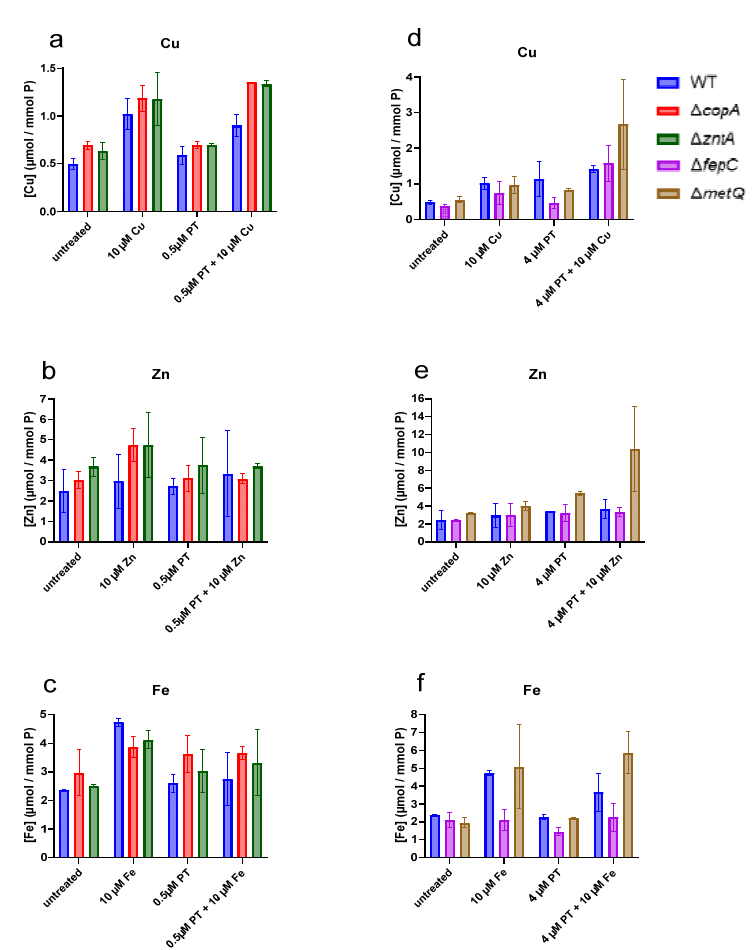
Figure 8. Cell-associated Cu, Zn, and Fe in wild-type (WT) E. coli K-12 BW25113 and the Keio knockout strains. ( a ) Cell-associated copper, ( b ) zinc, and ( c ) iron in the WT and knockout strains ∆ copA and ∆ zntA . ( d ) Cell-associated copper, ( e ) zinc, and ( f ) iron in WT and knockout strains ∆ fepC and ∆ metQ . Metal content was measured using ICP-MS as detailed in Materials and Methods and normalised to phosphorus for each sample. Data are shown as the average of two biological replicates taken with three technical replicates each, with the range indicated by the error bars.